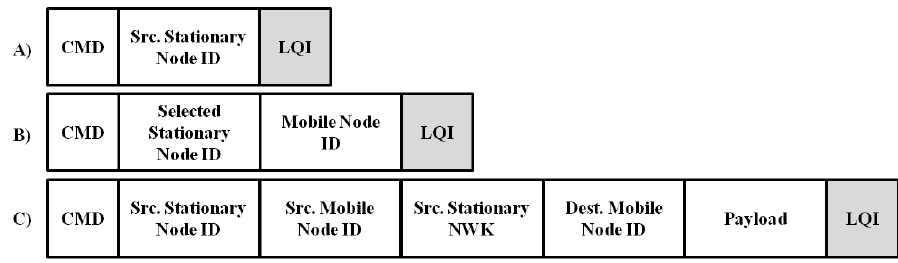
Figure 4. LIDx and LAMD packet formats (partial).